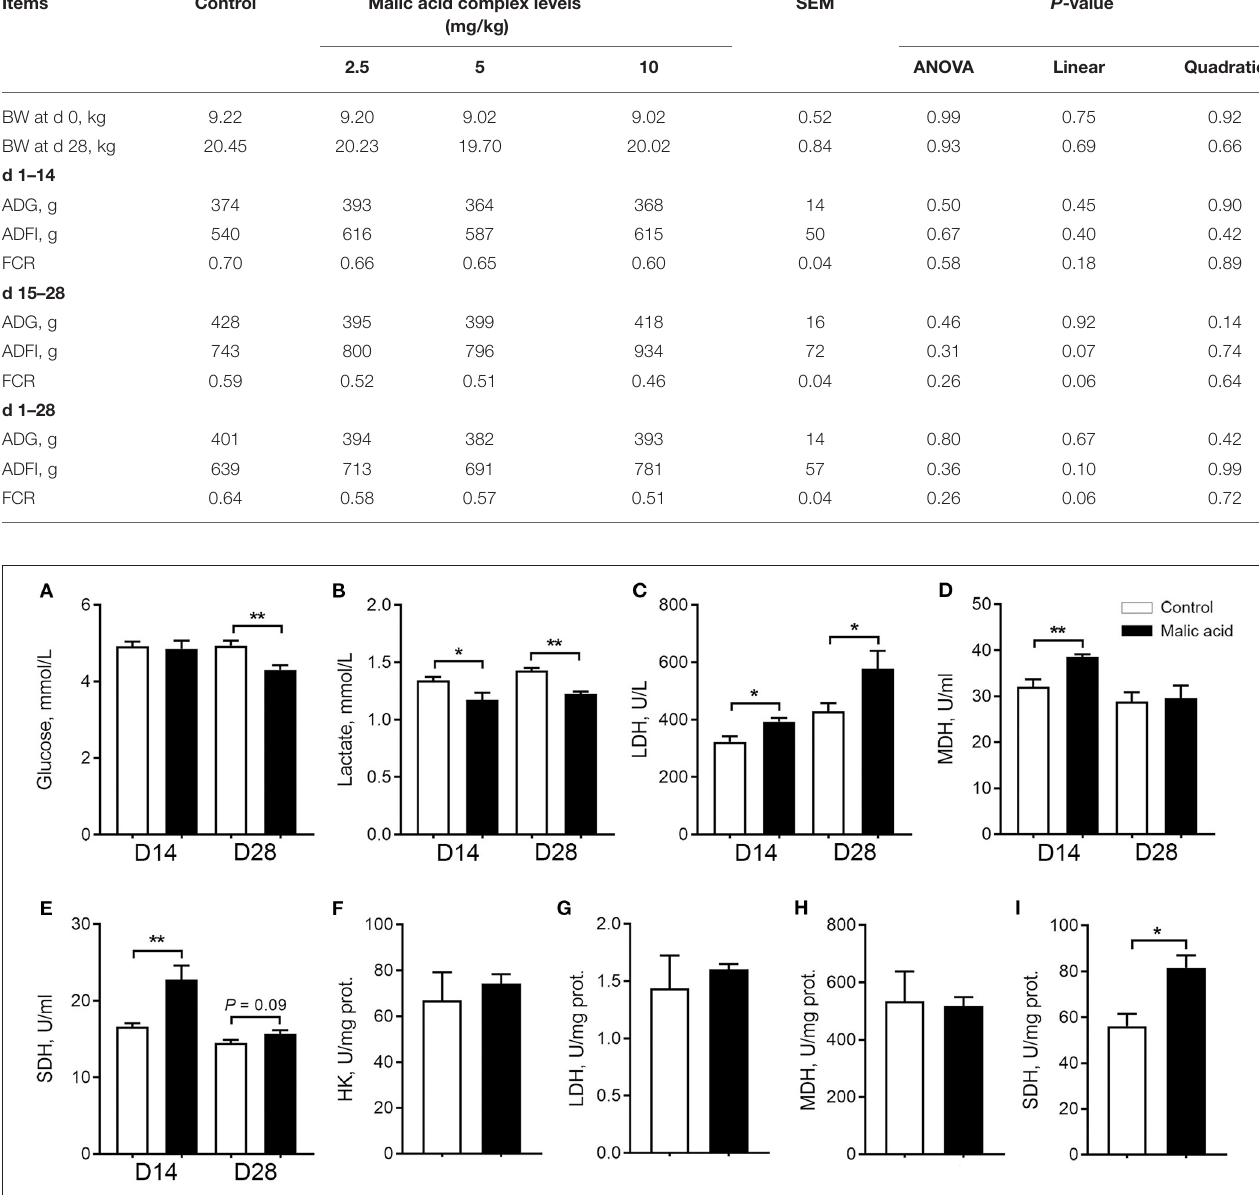
recorded. ADG, ADFI, and FCR were calculated as described in Experiment